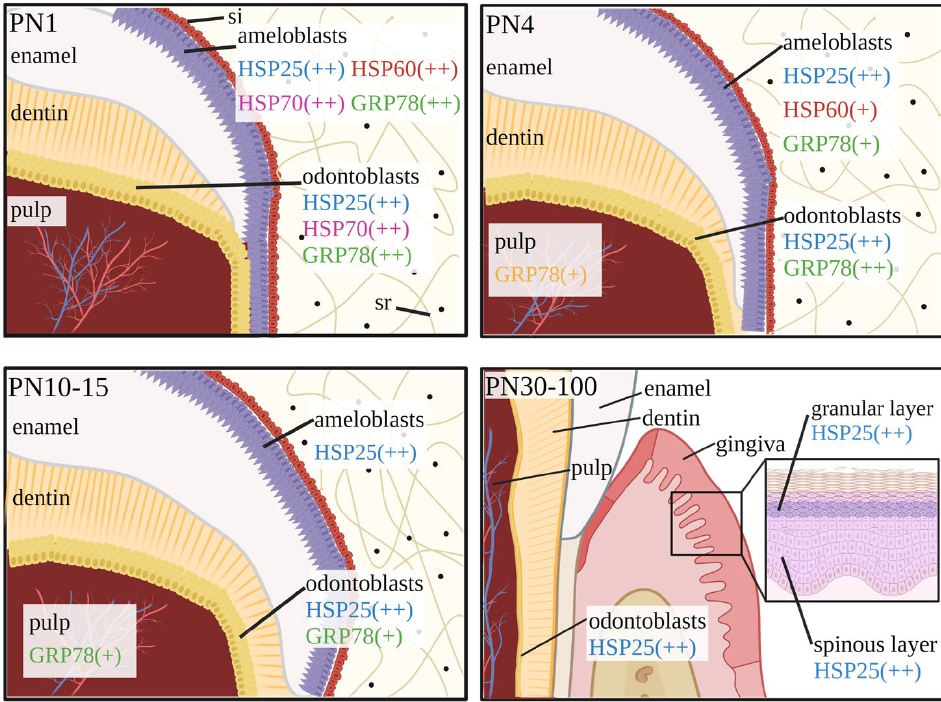
Figure 2. HSPs from postnatal day 1 to postnatal day 100 of mouse molar. The expression of HSP25 begins after odontoblasts and ameloblasts complete their differentiation, and HSP25 is strongly expressed when odontoblasts and ameloblasts secrete vigorously. When tooth development is basically completed, HSP25 is mainly expressed by odontoblasts. The expression of HSP60 and HSP70 peaked on PN2 and rapidly decreased. At the same time, the expression of GRP78 in ameloblasts is similar to that of HSP60. From PN4 to PN15, the expression of GRP78 continues in pulp, dentin and odontoblasts. At the time of tooth eruption, HSP25 is mainly localized in the spinous and granular layers of the gingival epithelium. (+): mild; (++): strong. Figures created with BioRender.com, accessed on 23 May 2022.